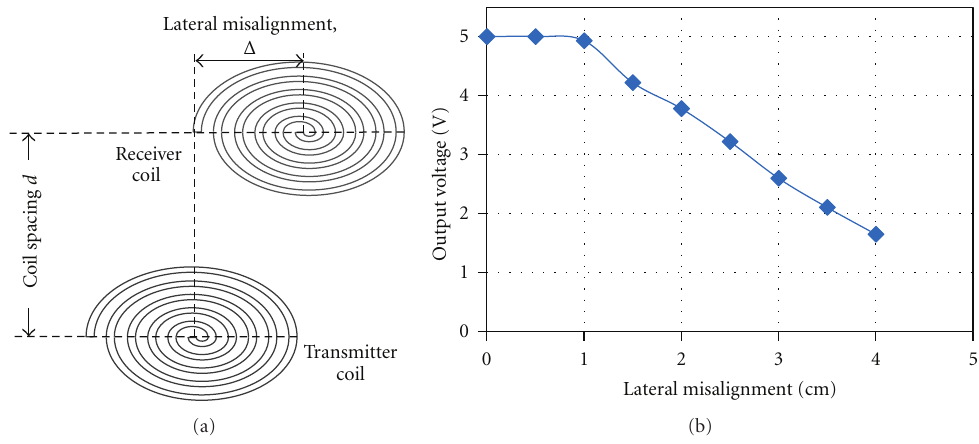
Figure 10: E ff ect of the variation of lateral misalignment ( Δ ) between the transmitter and the receiver coils: (a) the orientation of the coils. (b) the variation of the output voltage with increase in lateral misalignment. The coil spacing is kept fixed at 1cm.